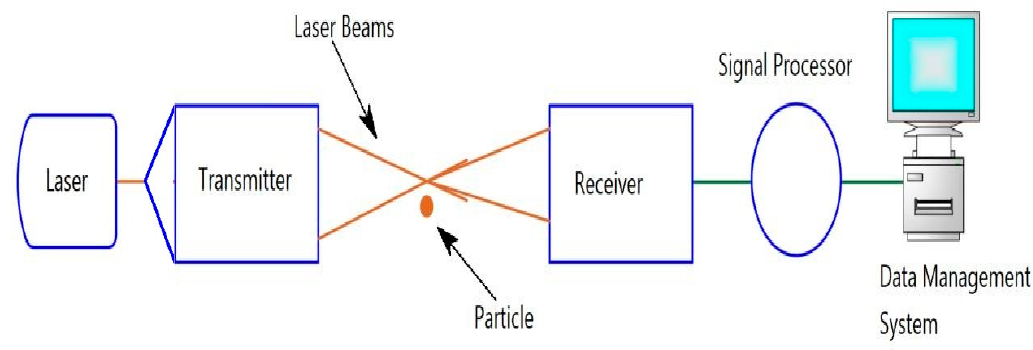
Figure 3. Schematic of a laser Doppler velocimetry system where monochromatic light is emitted towards the target and scattered light is detected by a photo multiple tube (PMT). Then, the Doppler shift is measured, which is a function of the target object relative velocity